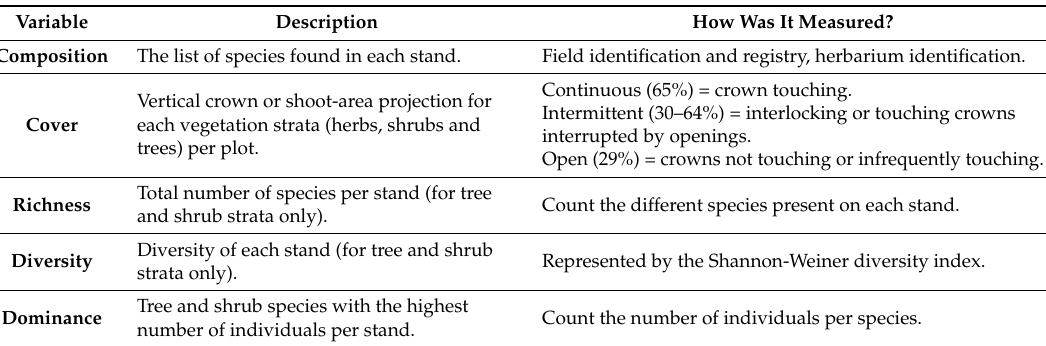
Table 3. Variables used for the vegetation